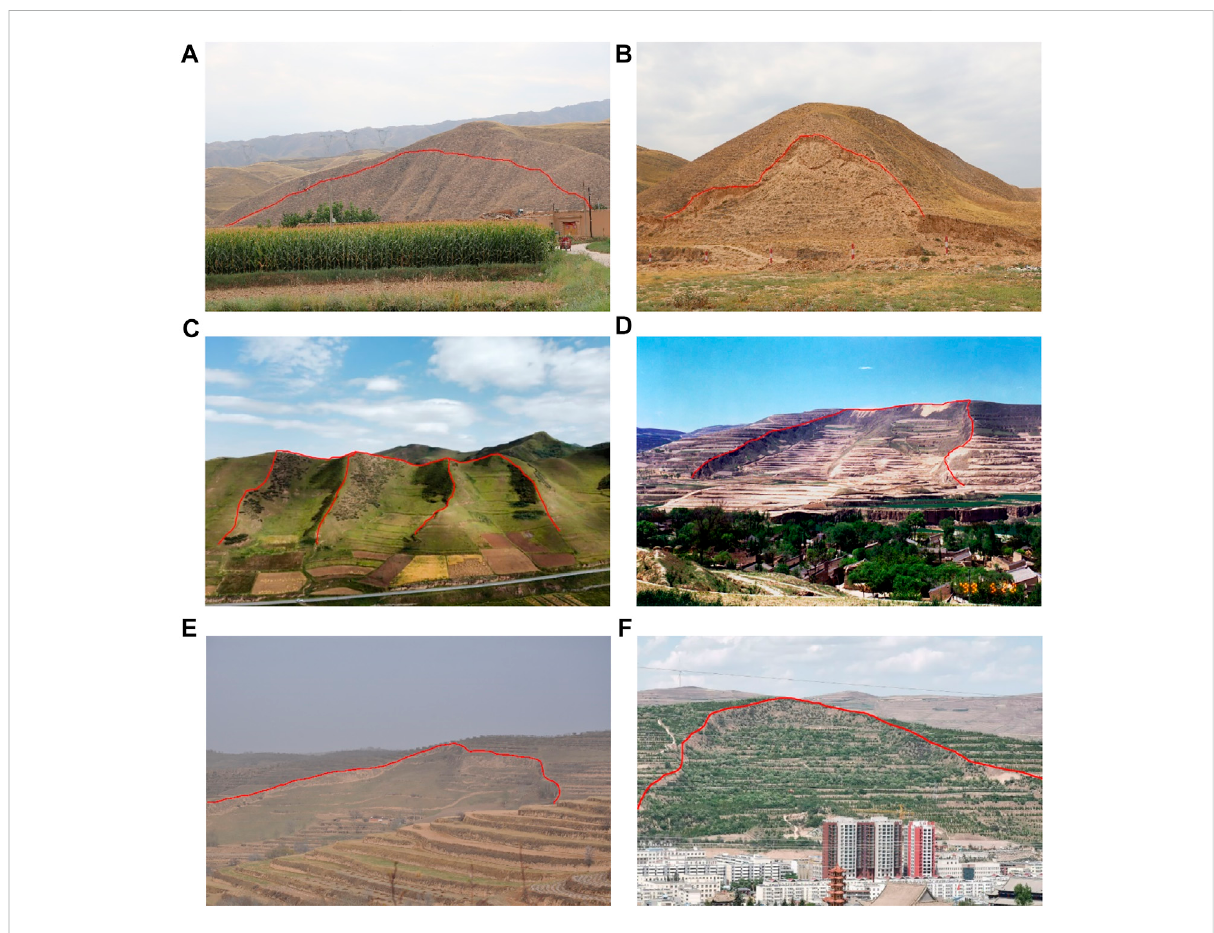
FIGURE 12 Typical loess seismic landslides in the study area and the Loess Plateau. (A) Landslide in Hejiazhuang; (B) landslide in Leixiangzhuang; (C) landslide in Siyangwa; (D) landslide in Sunjiagou, Jingning; (E) landslide in Huihuichuan, Xiji; and (F) landslide in